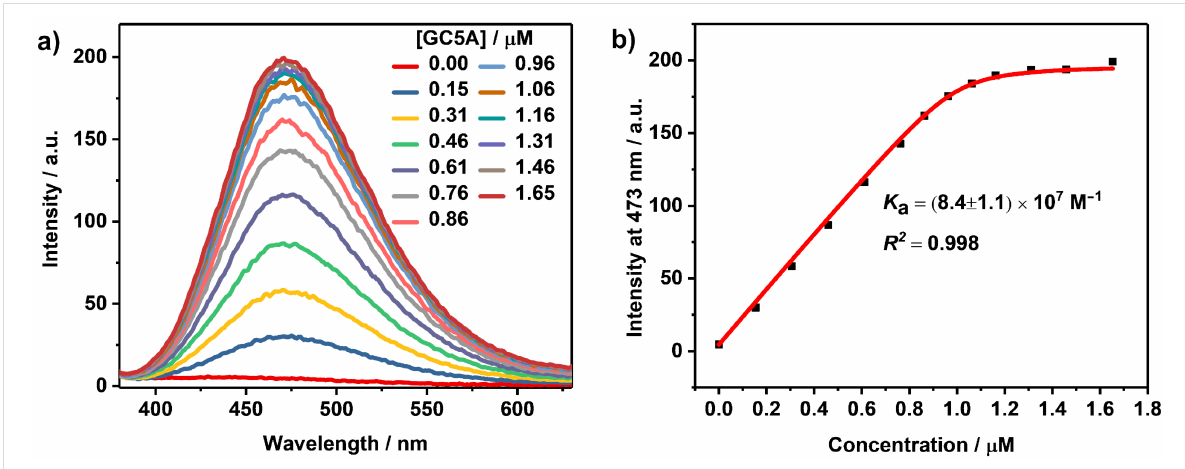
Figure 2: (a) Direct fluorescence titration ( λ ex = 327 nm) of P-TPE (1.0 μ M) with GC5A in HEPES buffer (10 mM, pH 7.4) at 25 °C and (b) the associ- ated titration curve ( λ em = 473 nm) fitting according to a 1:1 binding stoichiometry.